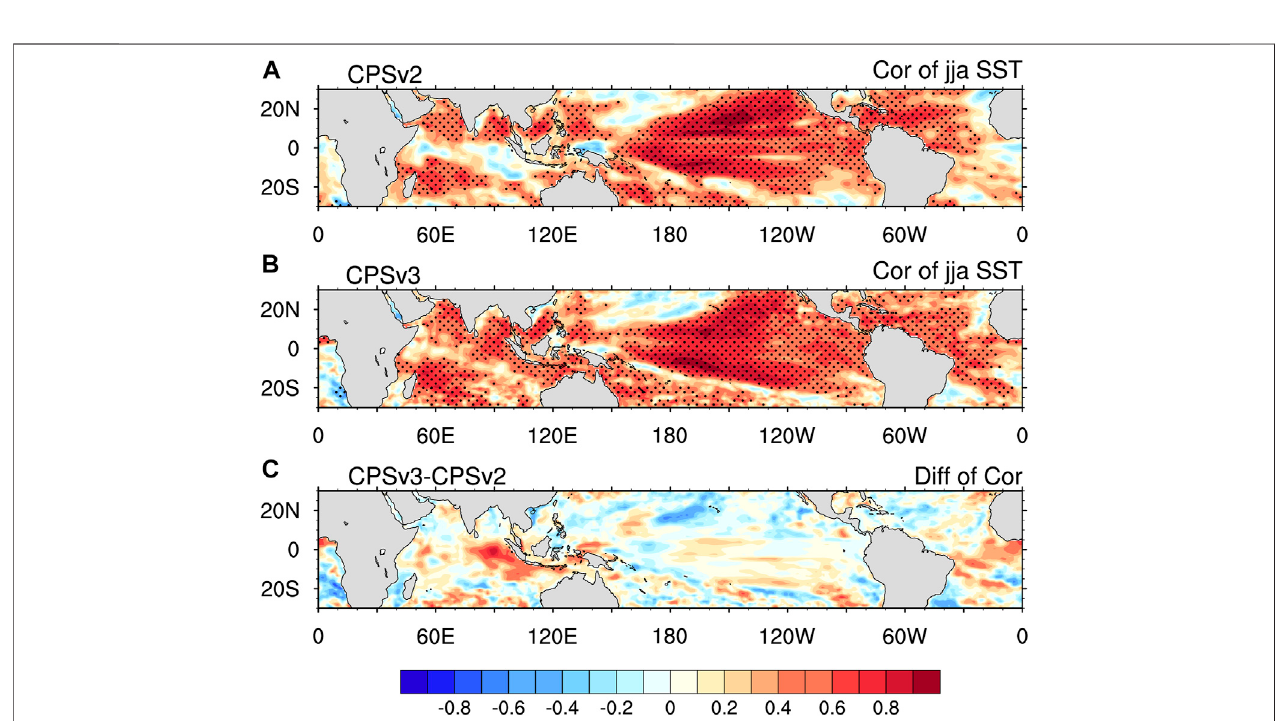
FIGURE8| TCCofJJASSTbetweenpredictionsandobservations. (A) CPSv2, (B) CPSv3, (C) differencebetween (A) and (B) (locationswithcorrelation valuesat the 5% signi fi cance level are highlighted by dots).